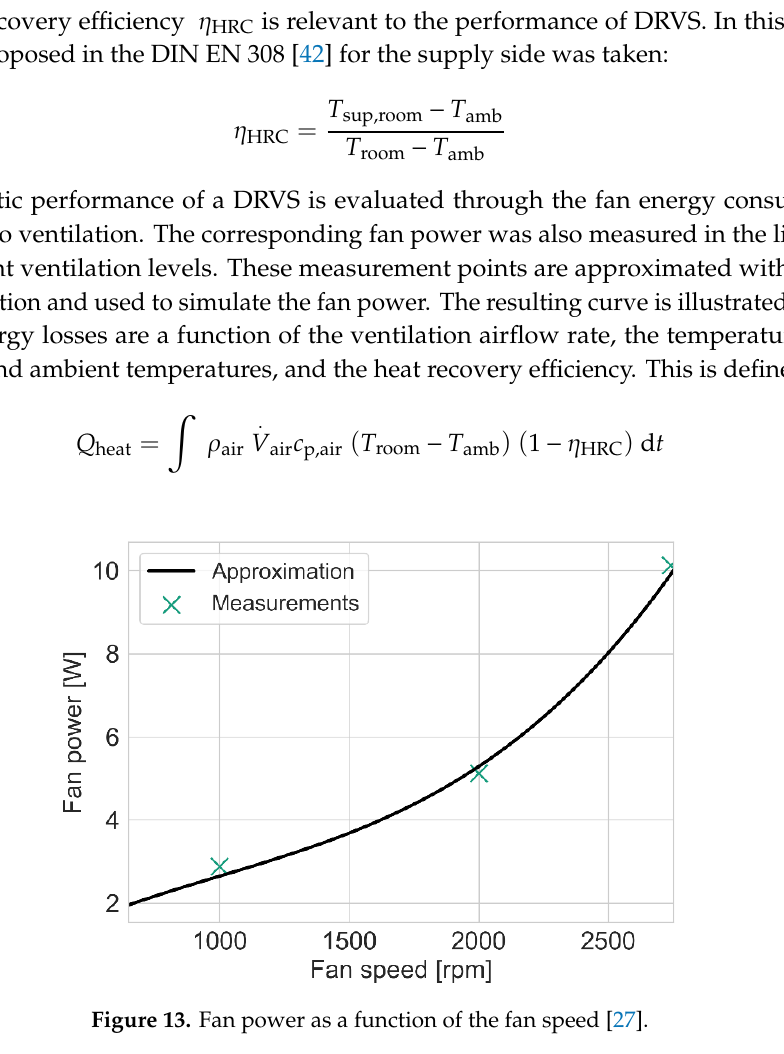
Figure 12. Fan speed in relationship to room relative humidity and CO 2 concentration.